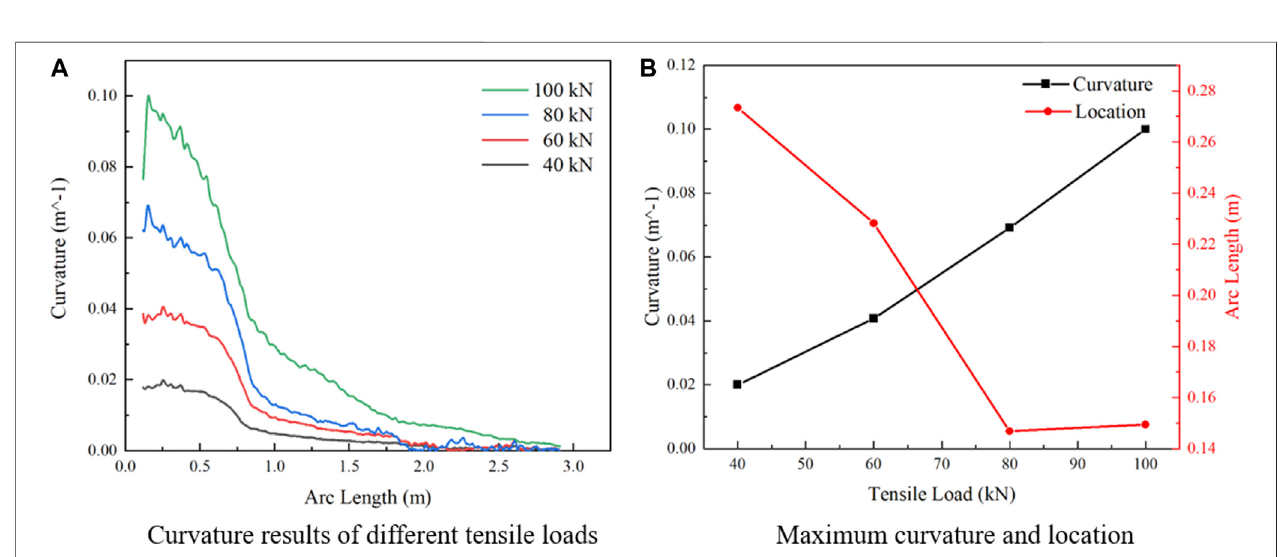
FIGURE 8 | Curvature results with different tensile